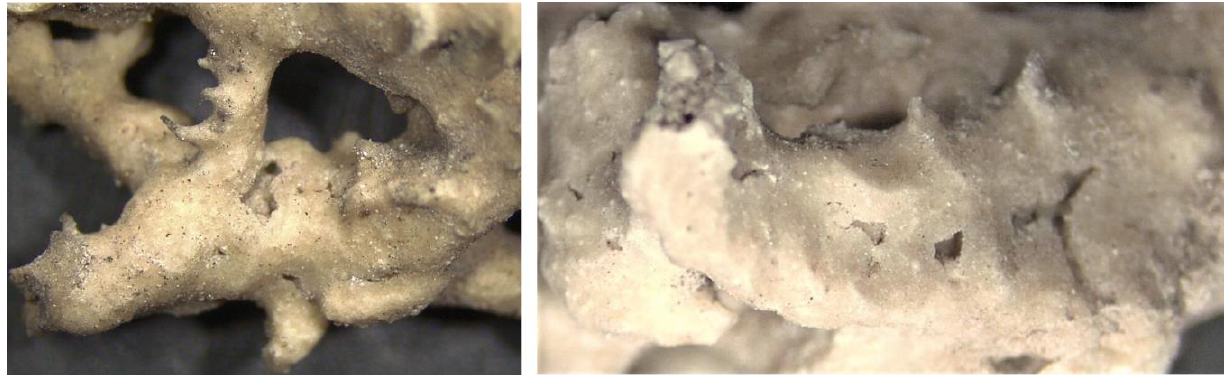
FIGURE 3: Stereomicroscope observations (20 x) of travertine material ornaments on CH Four Fontains fragment before (a-left) and after (b-right) the dry biocleaning technique (Photos credits to P. Di